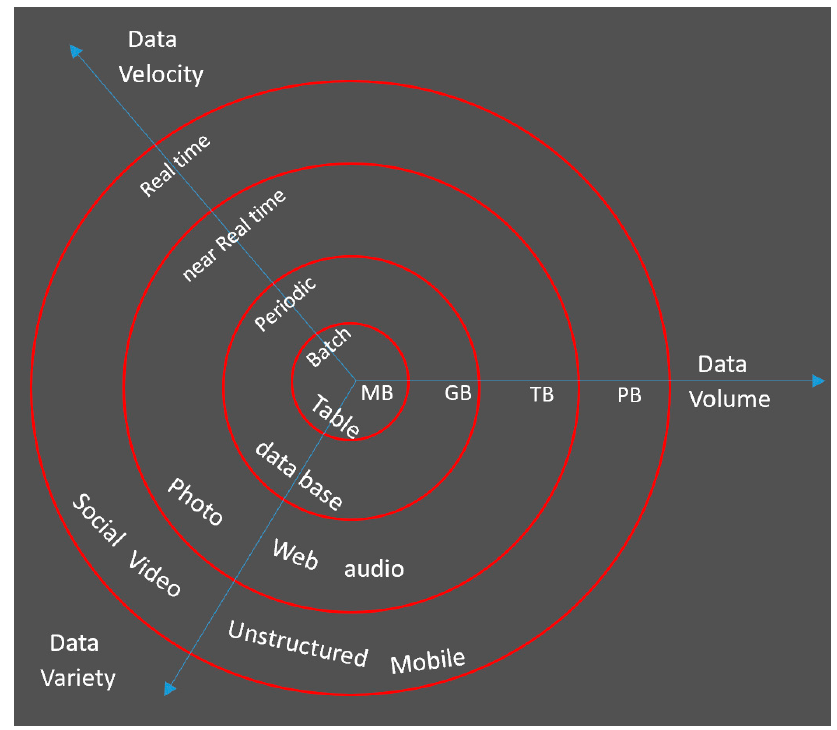
Figure 1. The 3Vs of big data (Soubra 2012).